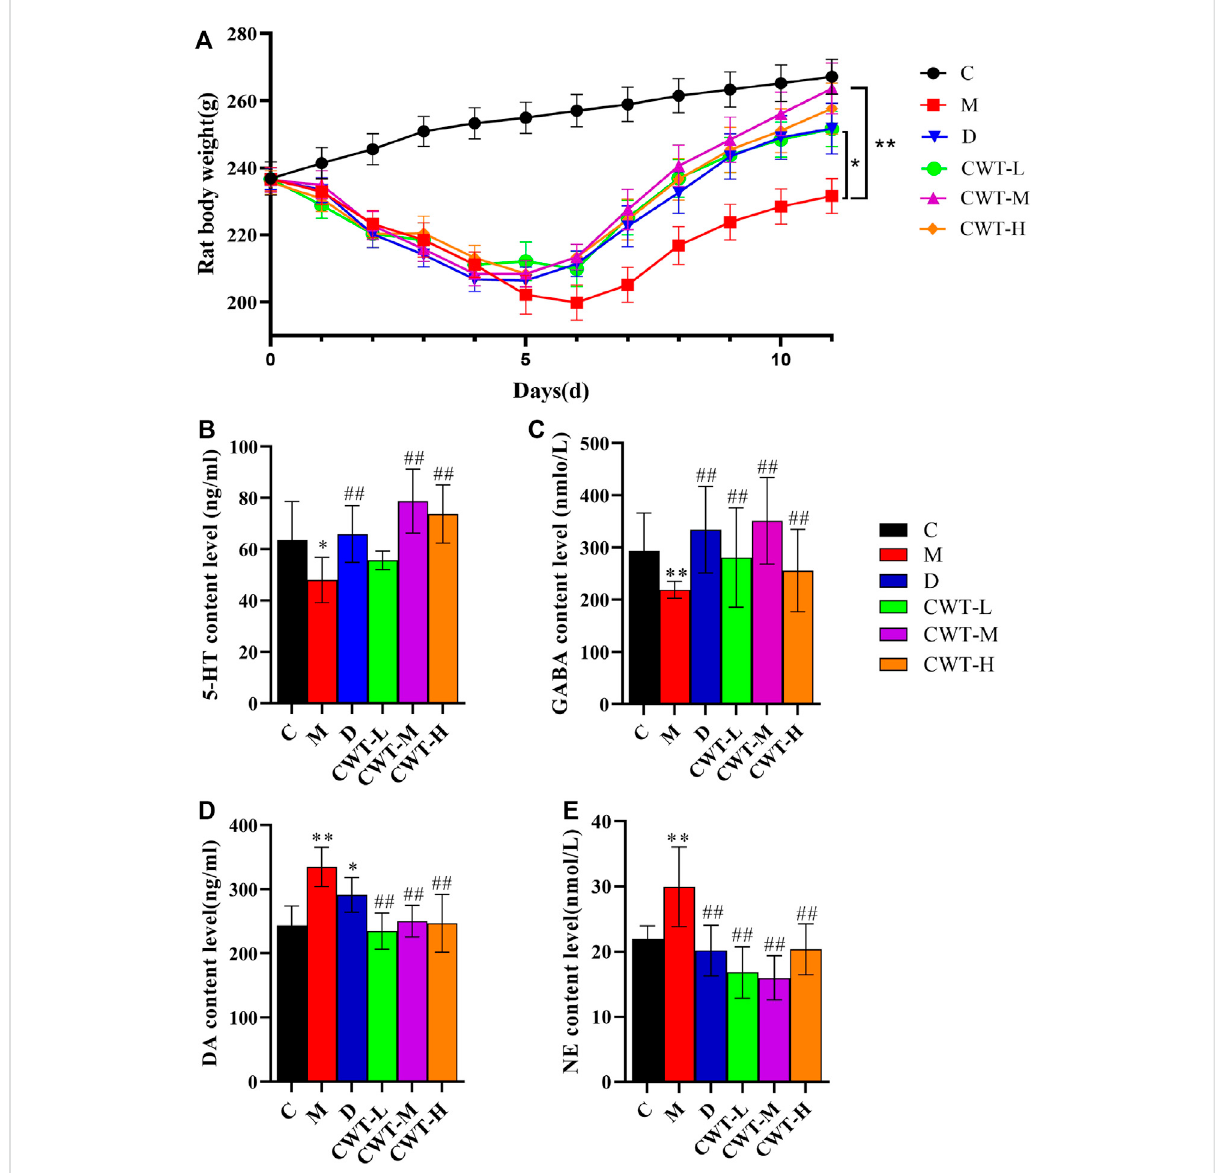
FIGURE 6 Body weight and biochemical evaluation (C, control group, n = 10; M, model group, n = 10; D: diazepam group, n = 10; CWT-L group, n = 10; CWT-M group, n = 10; CWT-H group, n = 10; compared with the C group, * p < 0.05, ** p < 0.01; compared with the M group, # p < 0.05, ## p < 0.01, mean±SD). (A) Bodyweightchangesineachgroupduringtreatment; (B) Analysisof5-HTcontentinthebrainsofrats; (C) AnalysisofGABAcontent; (D) Analysis of DA content; (E) Analysis of NE